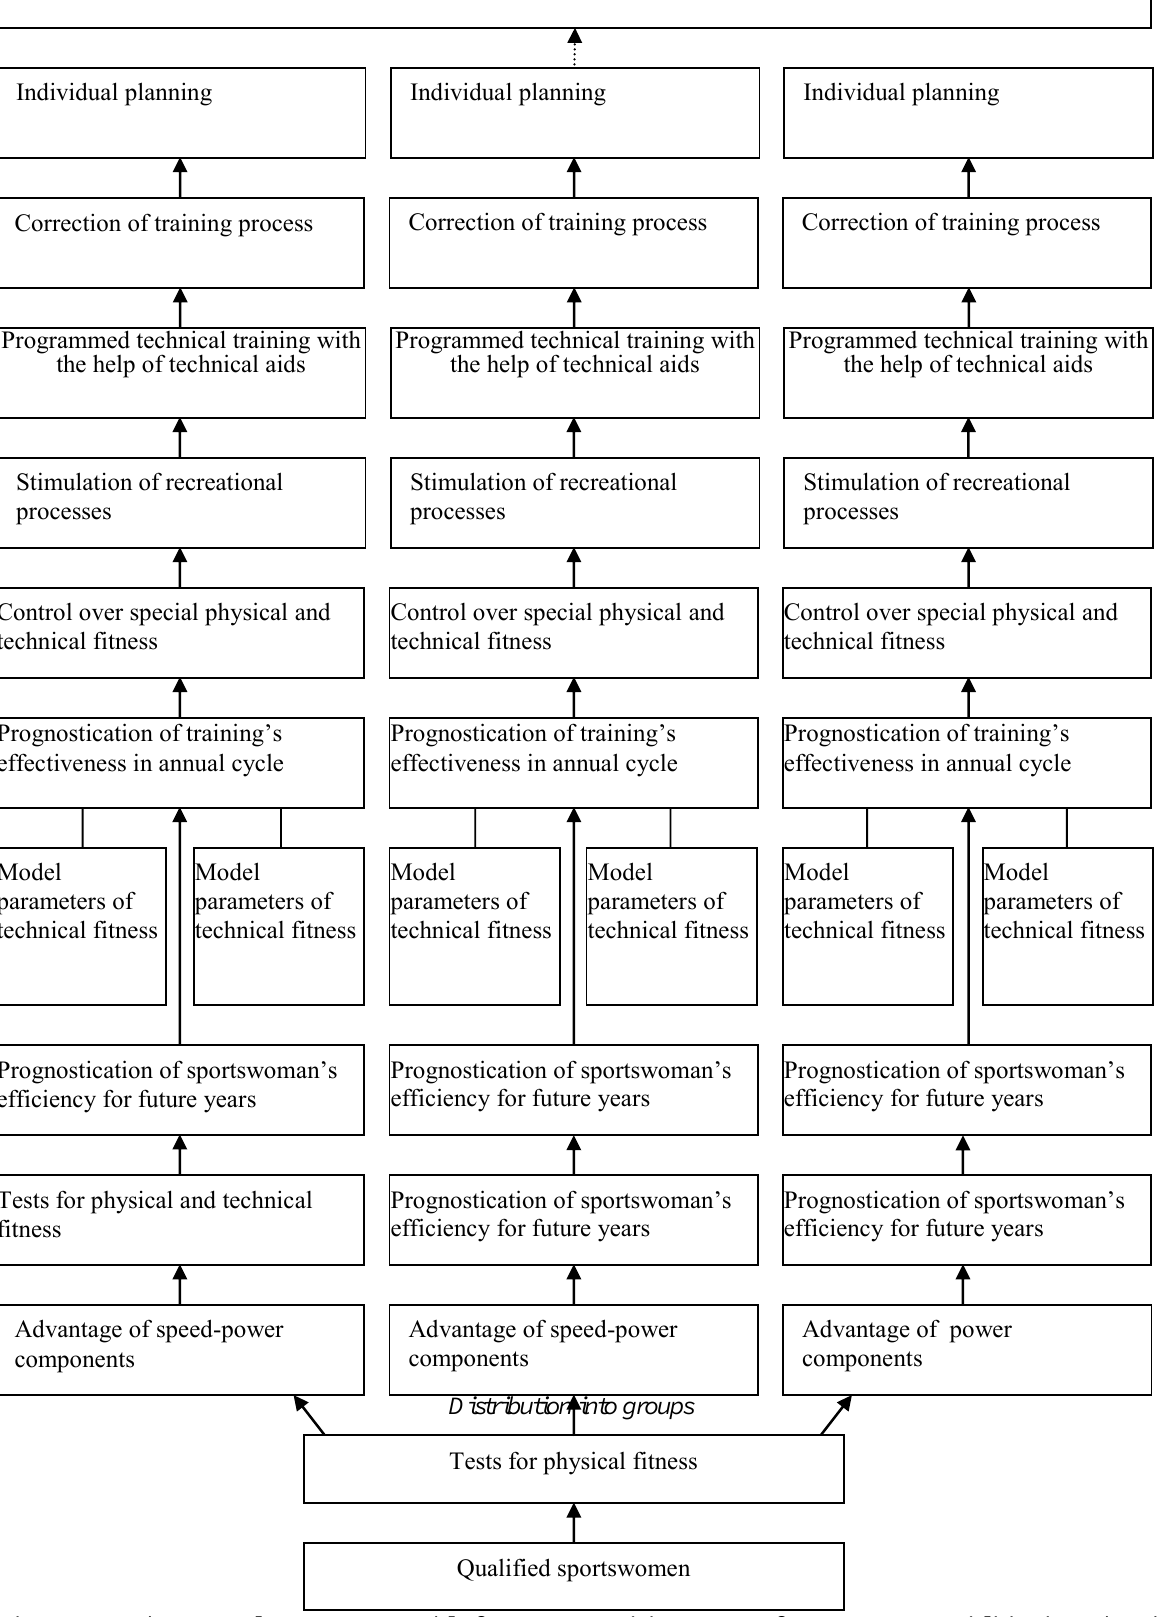
Fig.1. Improved conceptual management model of many years training process of sportswomen, specializing in track